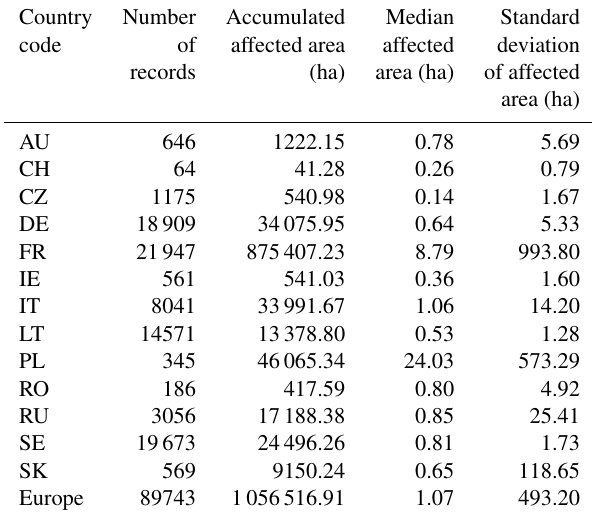
Table 4. Statistics of wind disturbance records collected in the FORWIND database aggregated at country level and for all of Eu-